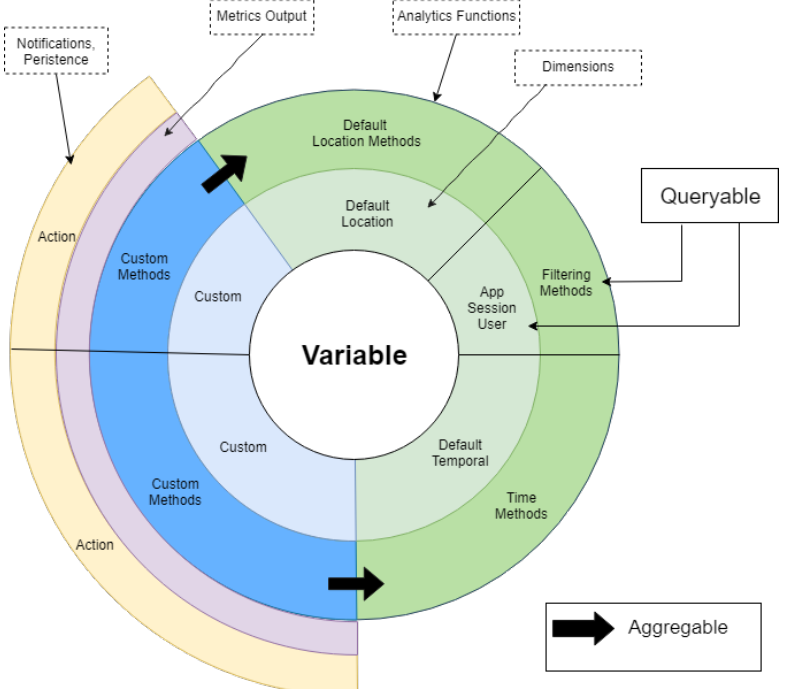
Figure 3. Representation of the relationships between dimensions, analytics functions, and actions. Black arrows denote that custom functions may combine (compose) default methods. Actions are only connected to results of custom analytics